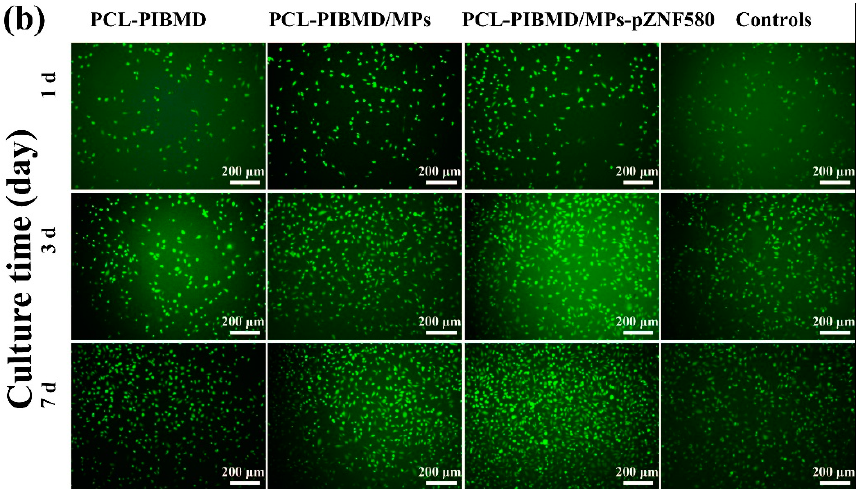
Figure 4. ( a ) EA.hy926 cells density (number of cells/mm 2 ). Error bars represent mean ± standard deviation (SD) (Fisher LSD test was performed to determine statistical significance between groups, * p < 0.05); ( b ) Fluorescence micrographs of EA.hy926 cells adhesion on PCL-PIBMD, PCL-PIBMD/MPs and PCL-PIBMD/MPs-pZNF580 meshes after 1, 3, and 7 days. Cells without treatment were taken as controls.